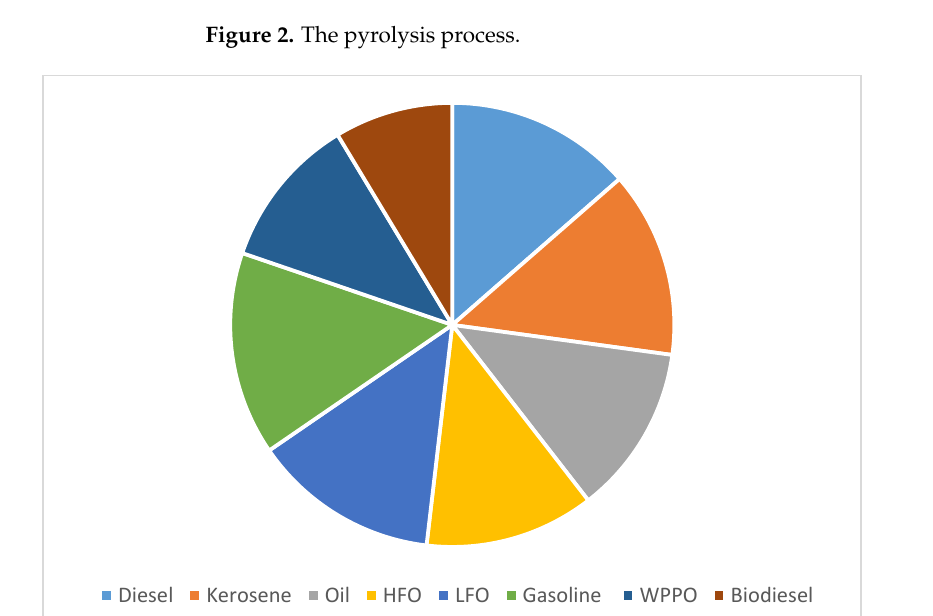
Figure 3. Similarity of plastic oil waste to the other fuel products [11] Table 1. Feedstock type and quantity [12].